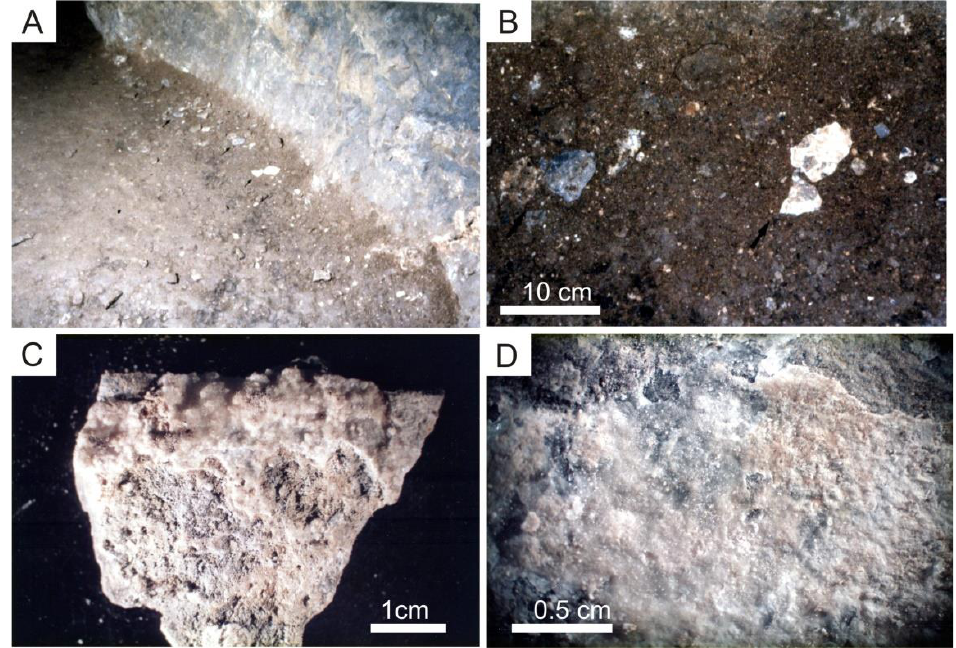
Figure 5. Alteration processes affecting to cave paintings. ( A ) General view of the floor of the sanctuary where abundant plates (flakes) detached from the wall can be seen. ( B ) Detail of the fallen flakes. ( C ) View of the back of a detached flake showing the alteration (disaggregation) of the host rock. ( D ) View of the back of a detached flake where a fine speleothem crust is observed.